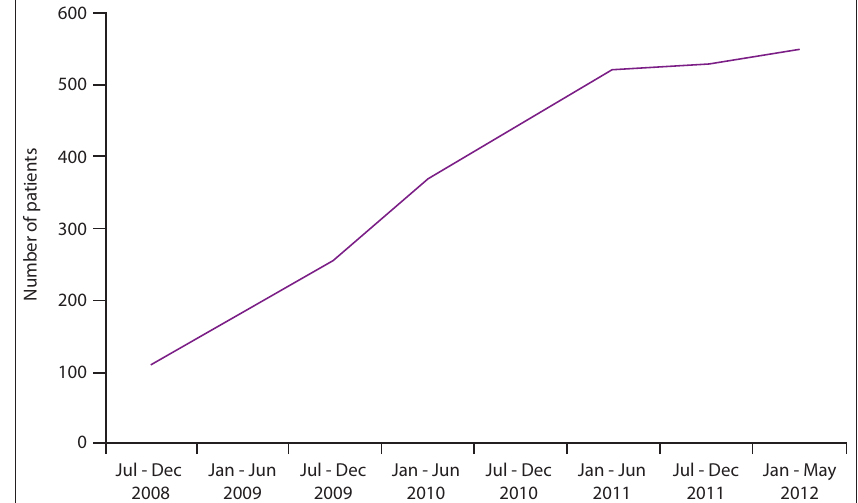
Fig. 1. Number of patients assessed by the mental health programme between July 2008 and May